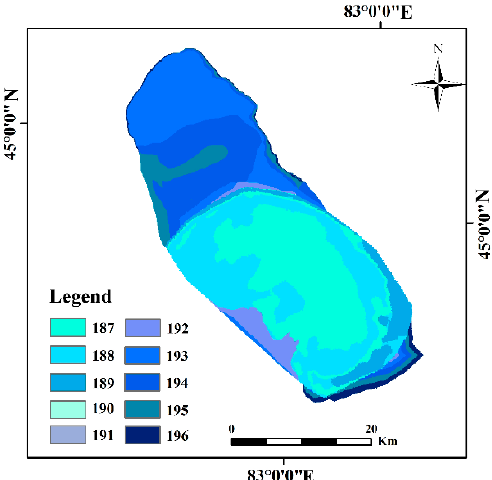
Remote Sens. 2021 , 13 , x FOR PEER REVIEW 13 of 20 Figure 8. Area change of Ebinur Lake by water level elevation. Figure 8. Area change of Ebinur Lake by water level elevation.